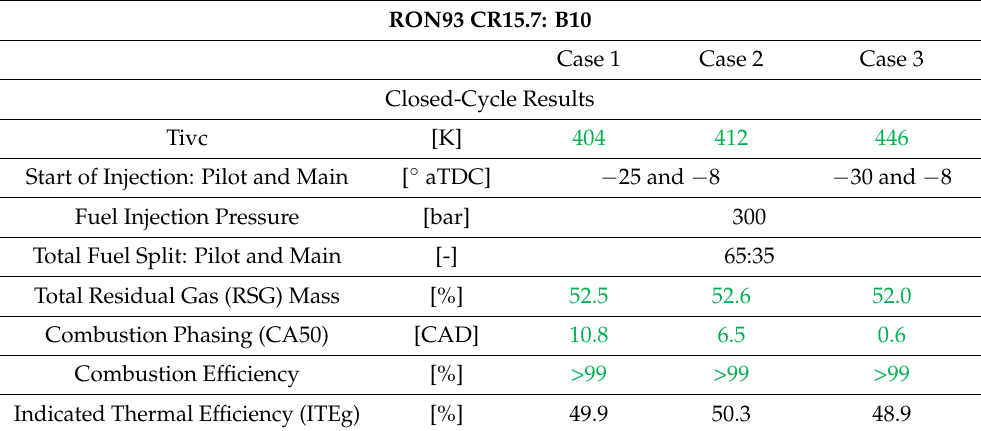
Table 4. Closed-cycle B10 performance at elevated Tivc levels.